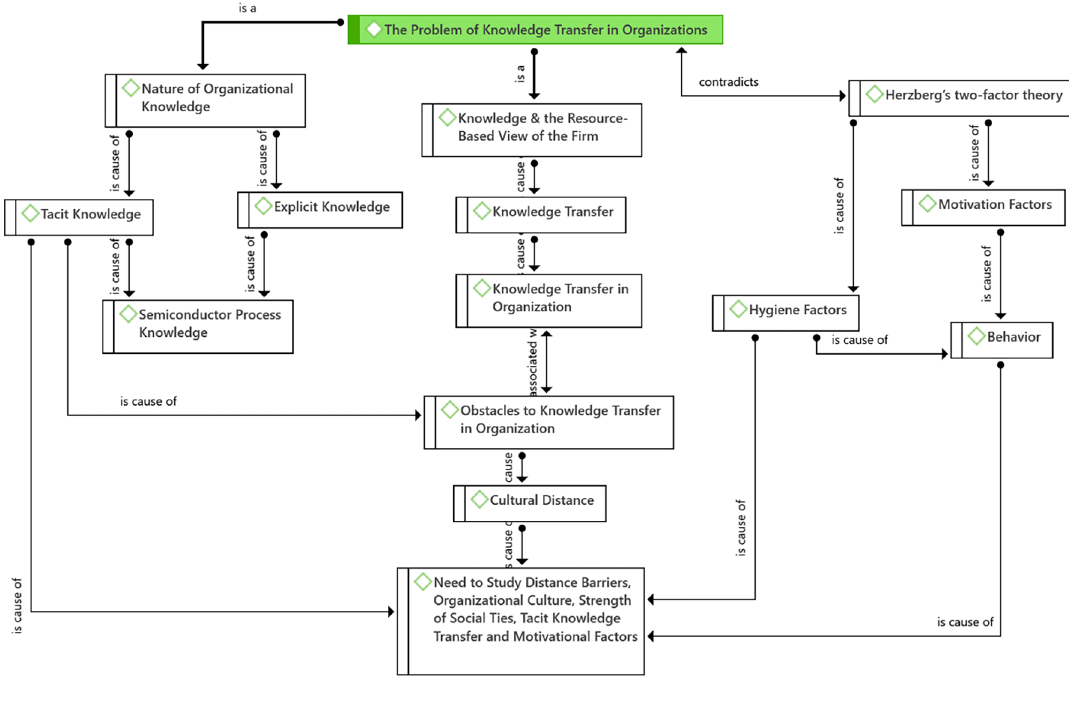
Figure 5. Literature review